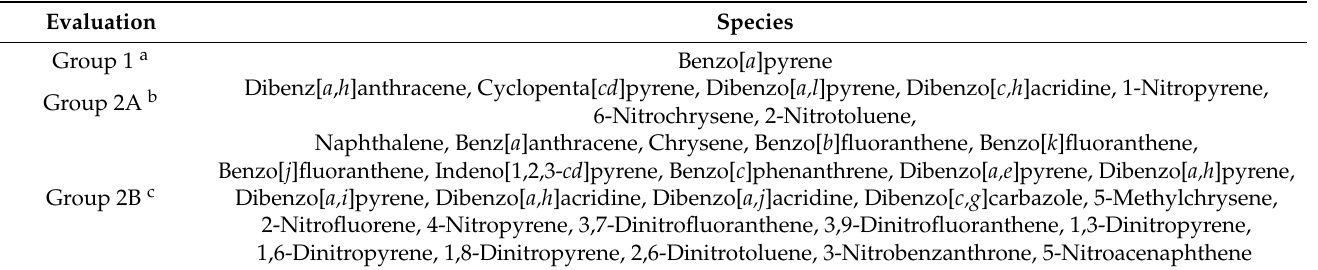
Table 3. Evaluation of PAHs (including heterocyclic PAHs) and their derivatives by IARC. Evaluation